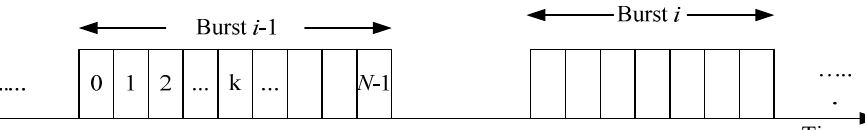
Figure 2. Communication model.